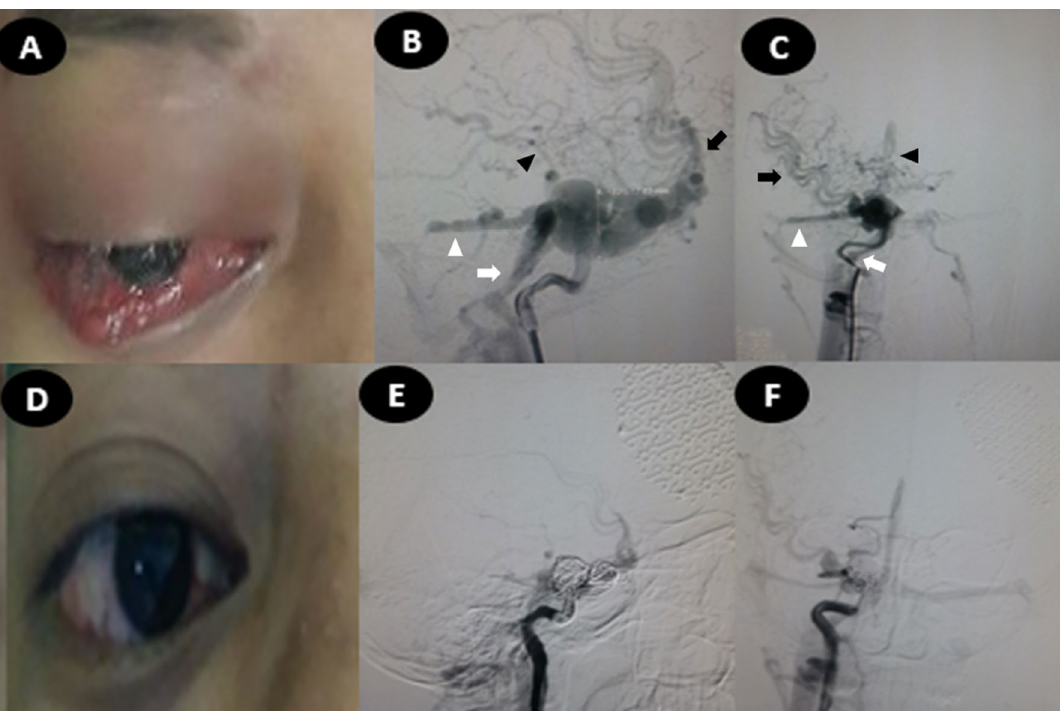
Fig. 2 Case 11, 17-year-old male developed progressive visual loss, proptosis, chemosis, cavernous sinus syndrome at his right eye ( A ) and left hemiparesis after motor vehicle accident. Initial angiogram ( B lateral view; C anteroposterior view) revealed Barrow type A CCF draining via the superior ophthalmic vein, superficial middle cerebral vein (arrows), basal vein of Rosenthal (arrowheads), superior petrosal sinus (white arrowheads), and inferior petrosal sinus (white arrows). After two episodes of embolization with detachable coil, there was immediate resolution of proptosis and chemosis, and his angiogram showed flow reduction through the